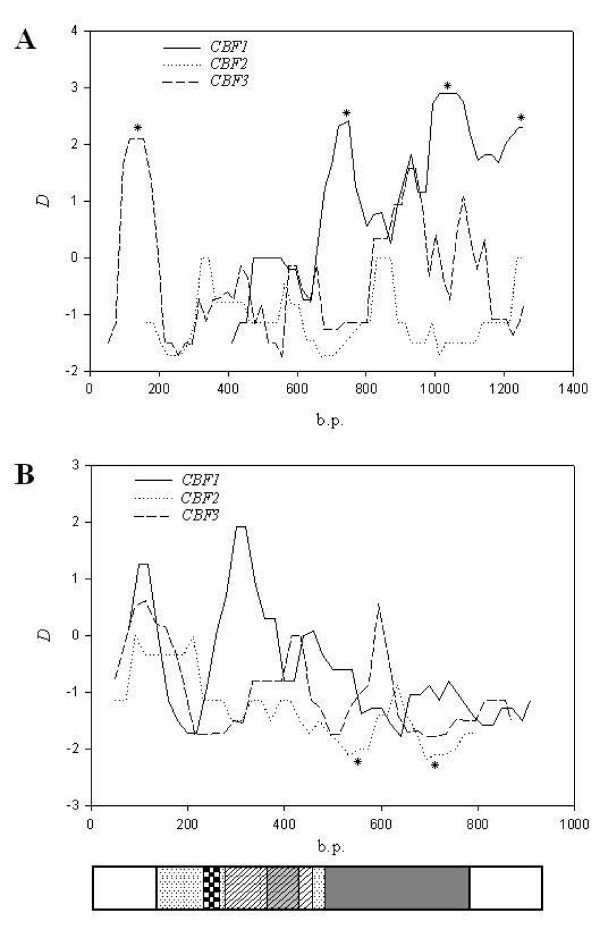
Sliding windows of Tajima's D tests along promoters (A) and transcriptional units (B) of CBF1, – 2, and – 3. Regions with significant positive or negative values (p < 0.05) are labeled with an asterisk (*). The scale of the sliding window plot was adjusted for the promoter regions. The last (3' end) sites of the promoter sequences of CBF1, -2, and -3 were placed in the same position. A transcriptional unit structure was placed under the corresponding nucleotide position. The window size is 100 bp, and the step size is 20 bp. An explanation of the boxes is given in the legend of Figure 1.